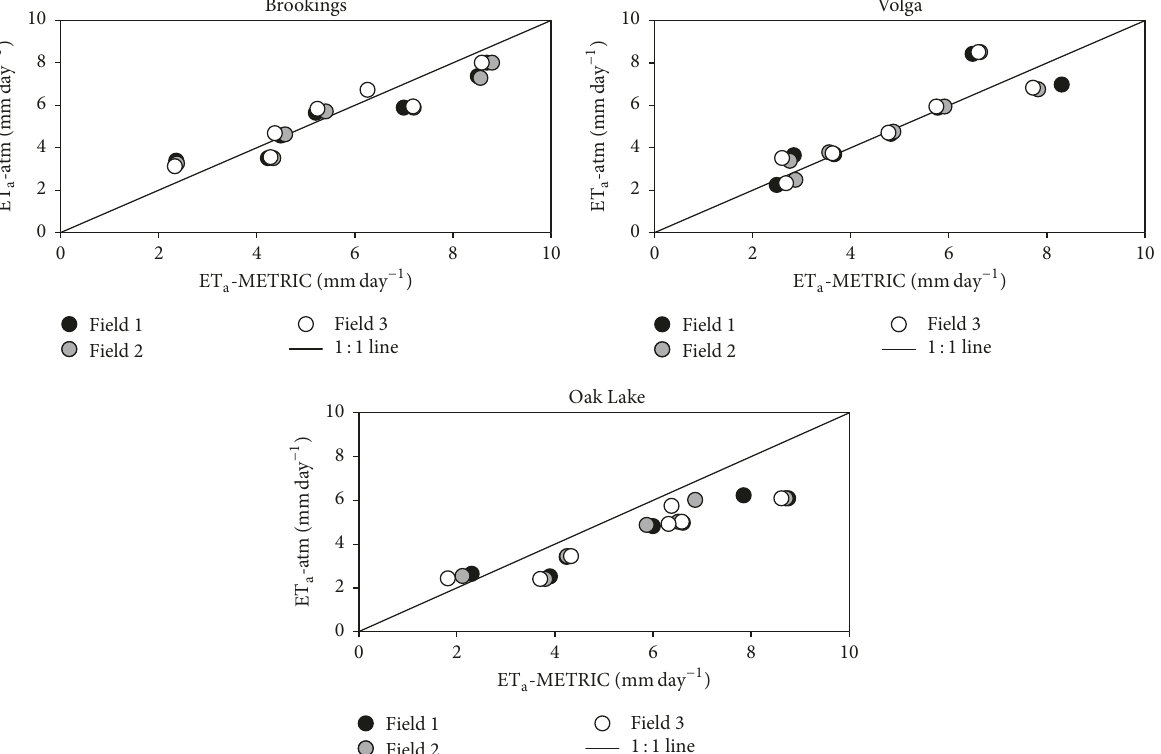
Figure 9: Relationship between ET season. The black line represents the 1: 1